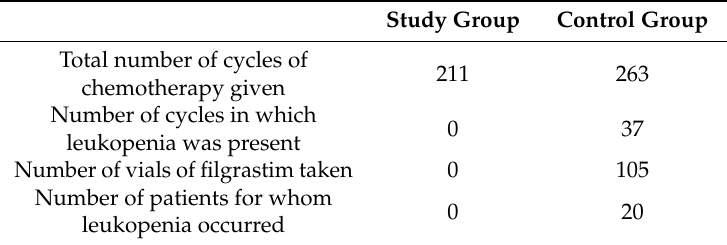
Table 3. Descriptive statistics for patients in study and control